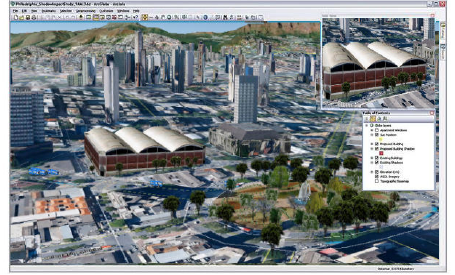
Figure 2 – Example of real model of Belo